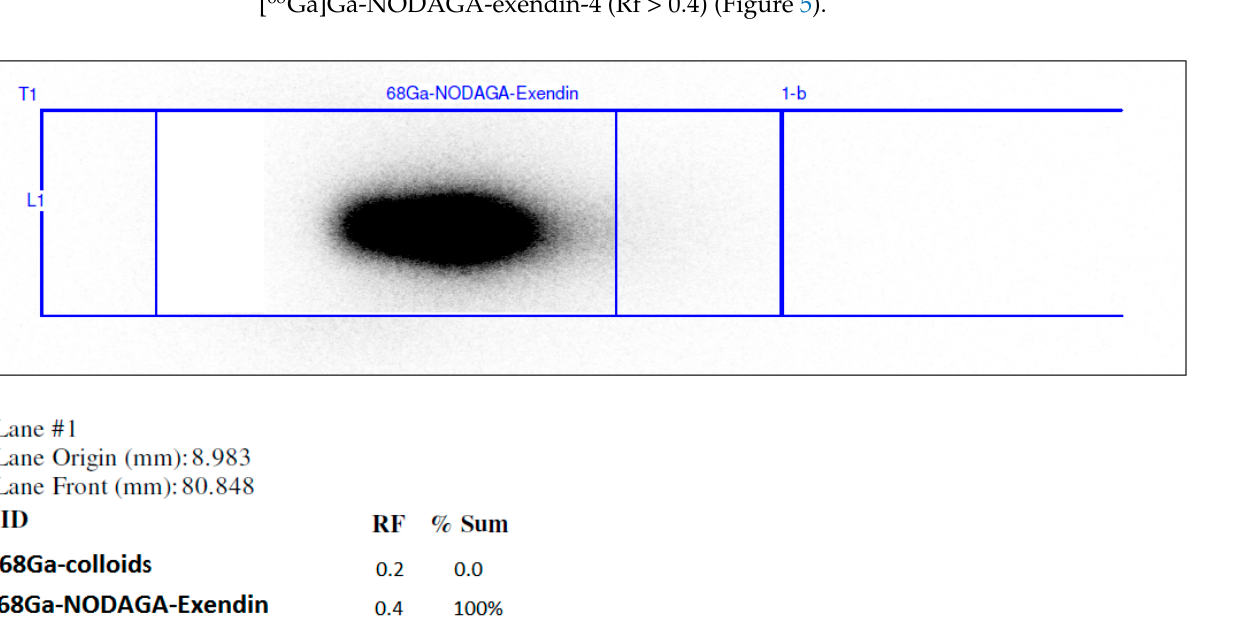
Figure 5. Radio-TLC of [ 68 Ga]Ga-NODAGA-exendin-4 conducted with ammonium acetate 1M pH 5.5 and DMF.Ga-68 colloids could be detected at Rf < 0.2 and [ 68 Ga]Ga-NODAGA-exendin-4 at Rf > 0.4 as showed in Supplementary Figure